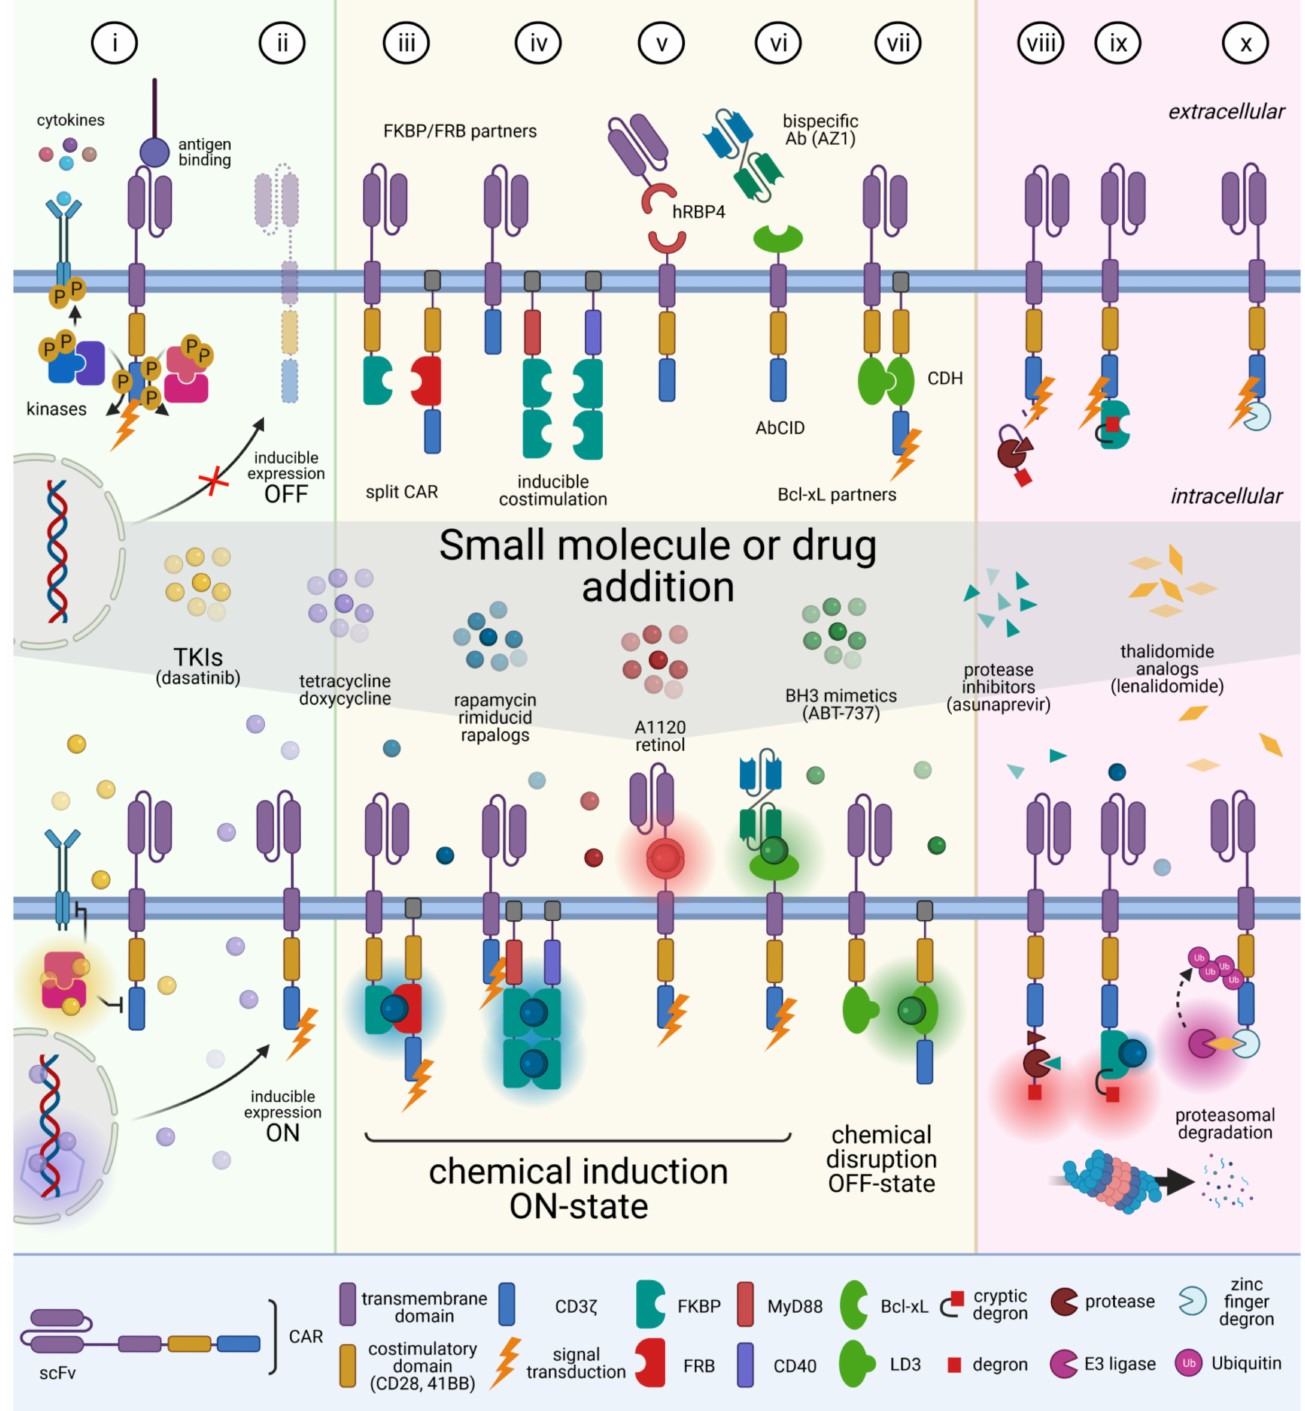
Figure 2. Pharmacologic strategies to reversibly control CAR function. Engineered CAR T cells can be commanded through signaling pathways and transgene expression (left panel), structural CAR component interactions (middle panel) or targeting CAR for proteolysis (right panel). See the main text for detailed descriptions. Created with